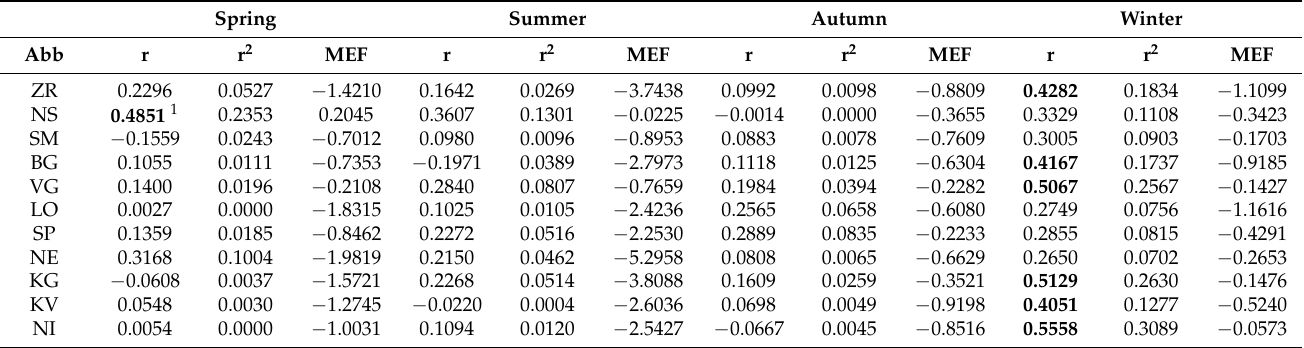
Table 10. Seasonal results from linear regression models for Tn10.